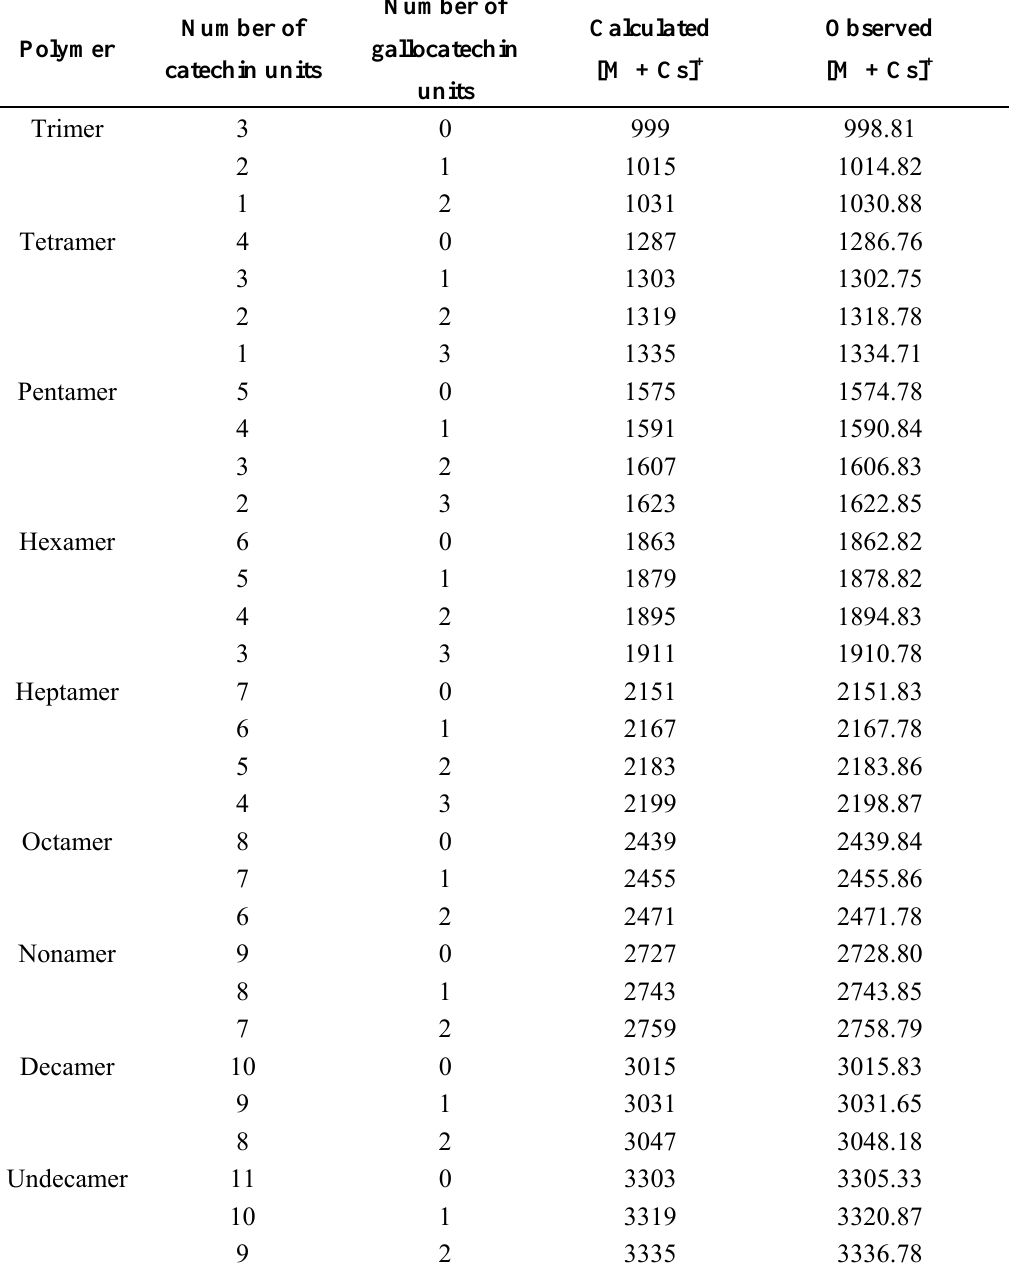
Table 2. Observed and calculated masses a of heteropolyflavan-3-ols by MALDI-TOF MS.